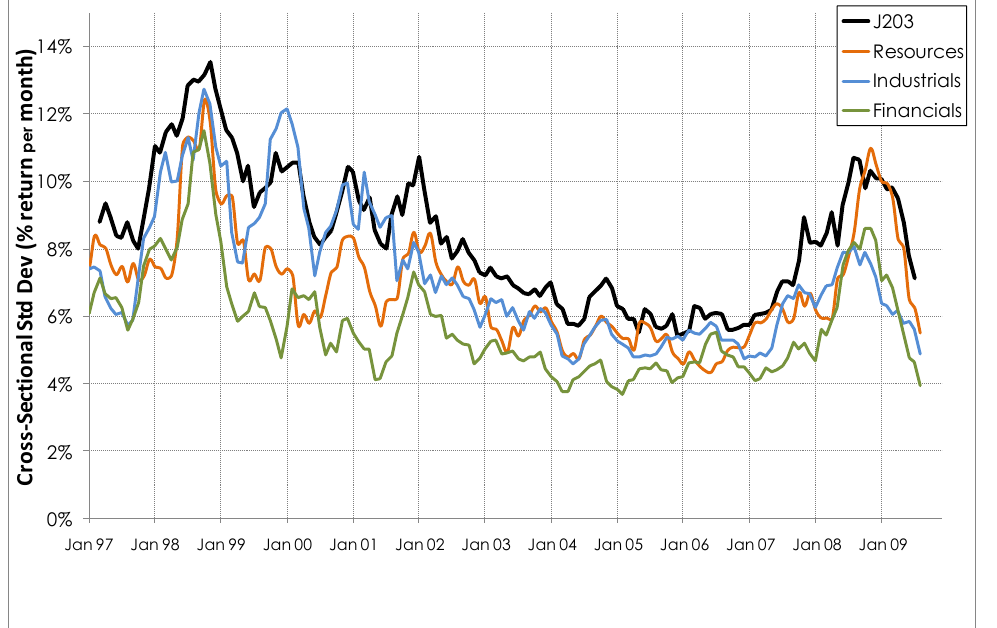
Figure 3: Cross-sectional standard deviation on the FTSE/JSE sectors over